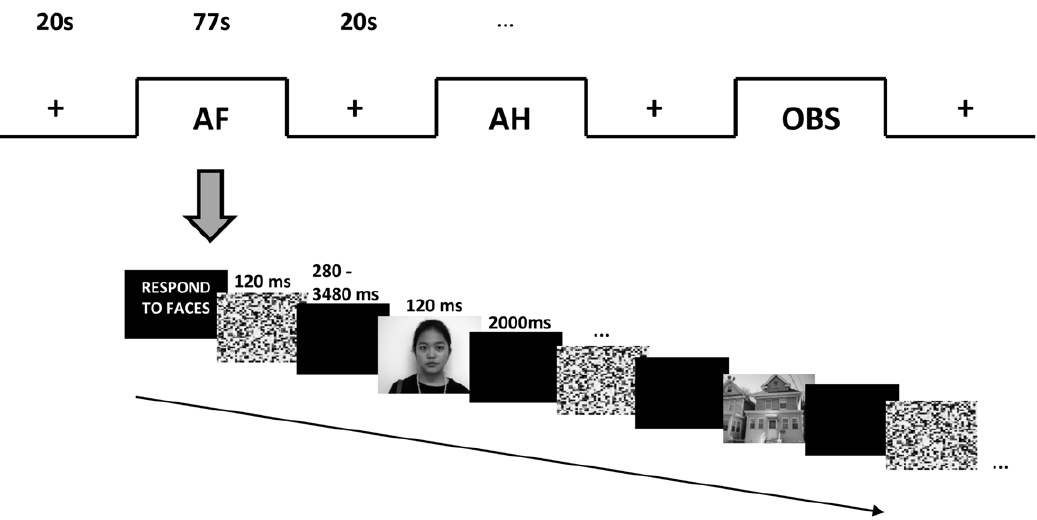
Figure 1. Schematic of the object-selective attention task. Three faces and three houses were presented during every task block. Inter- stimulus intervals varied randomly after each scrambled image, and were held constant at 2000 ms following each target. Subjects performed 6 task runs during each scanning session. AF = attend and respond to faces; AH = attend and respond to houses; OBS = passive observation of houses and faces.